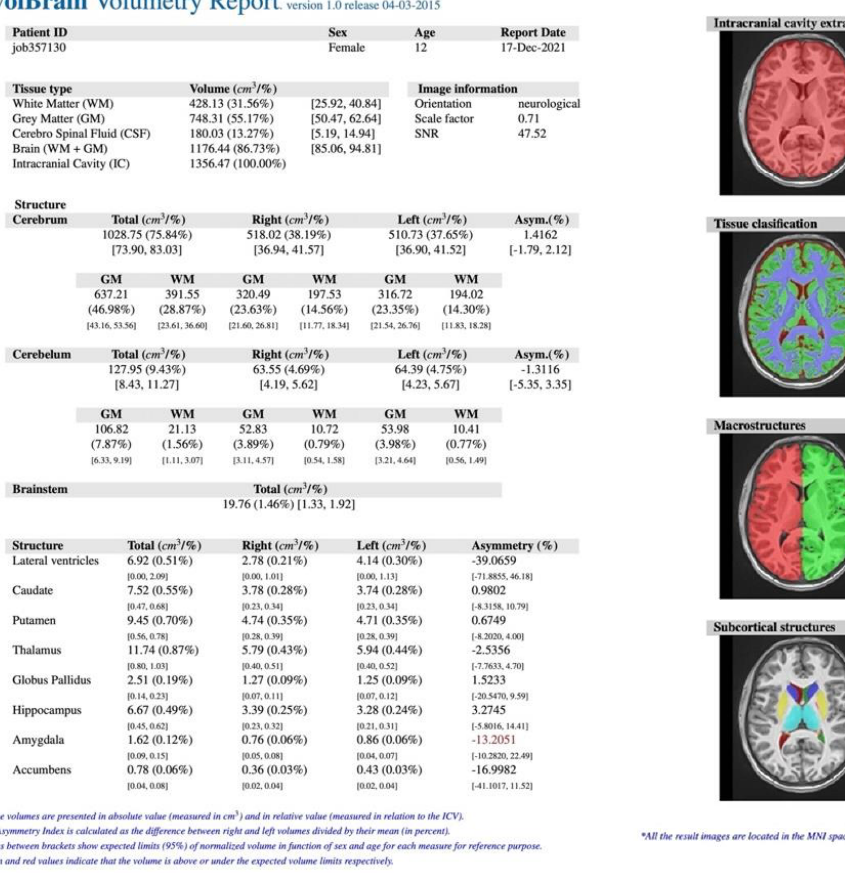
Figure 1. Example of volBrain pdf report. The report consisted of several parts. At the top, there is hidden patient data with a randomly assigned number plus age and gender. The next section lists the measured structures: ( A ) macrostructures such as WM, GM, CSF, IC, cerebrum, cerebellum, brainstem, and subcortical, ( B ) microstructures such as putamen, caudate, pallidum, thalamus, hippocampus, amygdala, and nucleus accumbens. Values are expressed in cubic centimeters and percentages. On the right, there is a visual example of the segmentation process (axial, sagittal, and coronal views) to certify its quality. Source: own study.